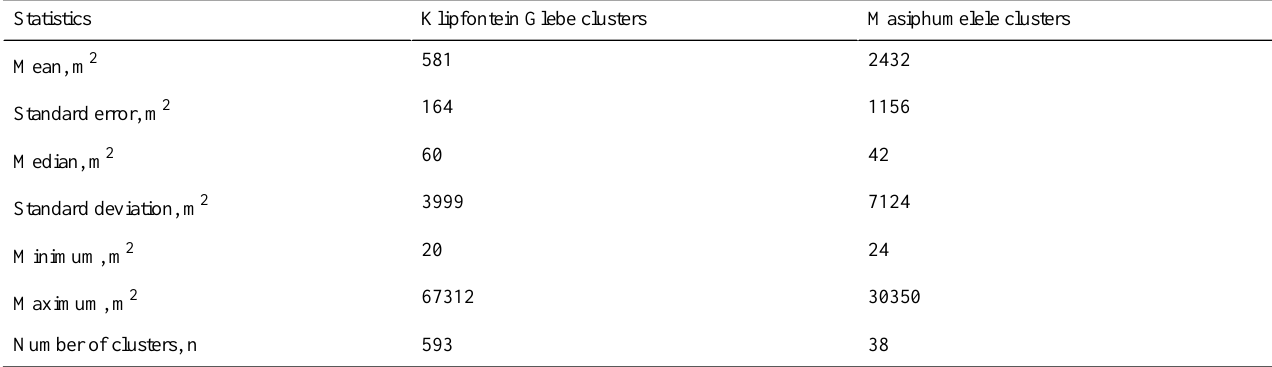
Table 1. Descriptive statistics of the size (m2) of clusters in Klipfontein Glebe and